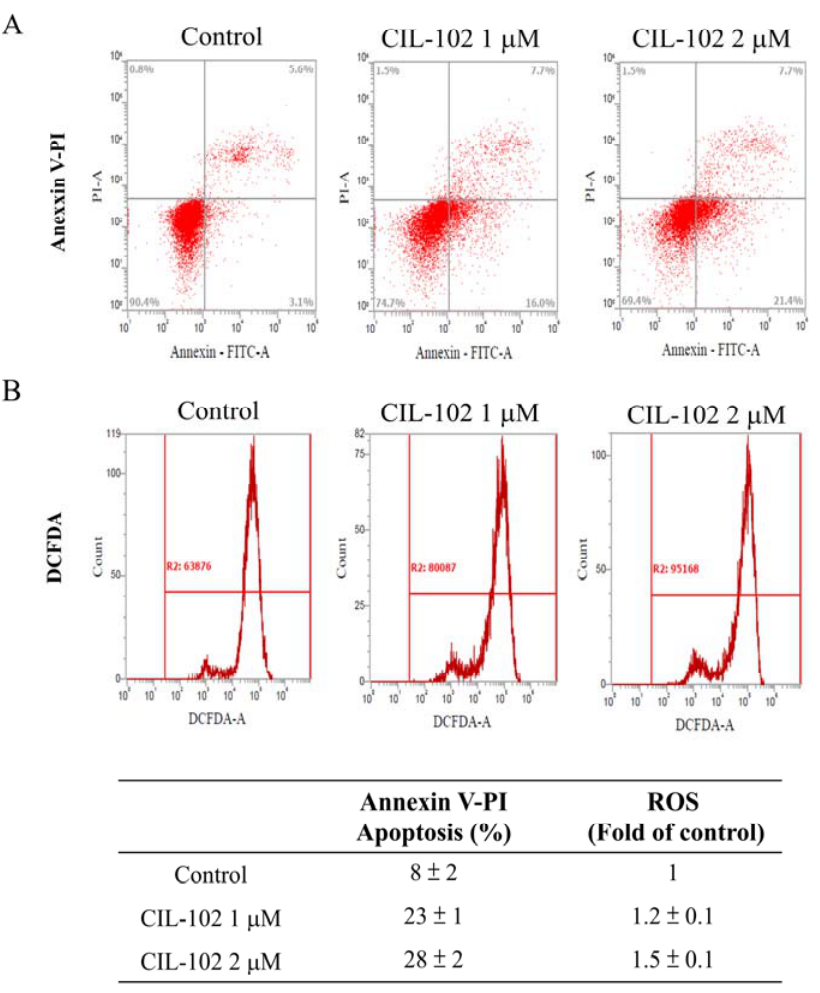
Figure 2. CIL-102 treatment induces cell apoptosis and the ROS production of DLD-1 cells. ( A ) FITC-conjugated Annexin-V and PI stainings of DLD-1 cells, with or without CIL-102 treatment, for 24 h were performed by flow cytometry analysis, as described in the Materials and Methods sections. The percentages of the apoptotic or neurosis cells in these treated cells are shown in each frame, as indicated. ( B ) Intracellular ROS of DLD-1 cells treated, with or without CIL-102, at 1- and 2- μ M concentrations for 24 h was measured by a FACS analysis, as described in the Materials and Methods sections. Representative histograms of typical H2DCFDA profiles are shown. The production of ROS was expressed as the fold of the control group. Data are presented, based on three independent experiments, as mean ± S.D.